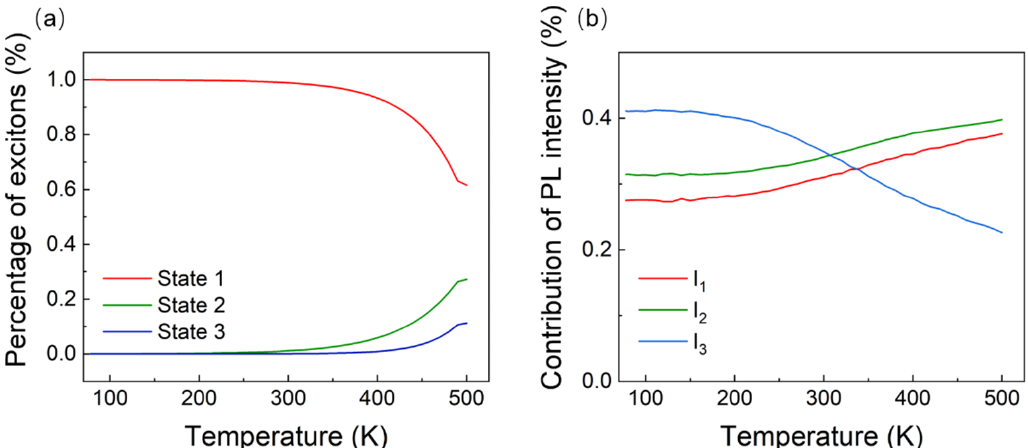
Figure 6. ( a ) Variation in the percentages of the three types of excitons in a [MnBr 4 ]BrCs 3 film with increasing temperature. ( b ) Variation of the ratio of the PL intensity contributed from the three types of excitons in a [MnBr 4 ]BrCs 3 film with increasing temperature.